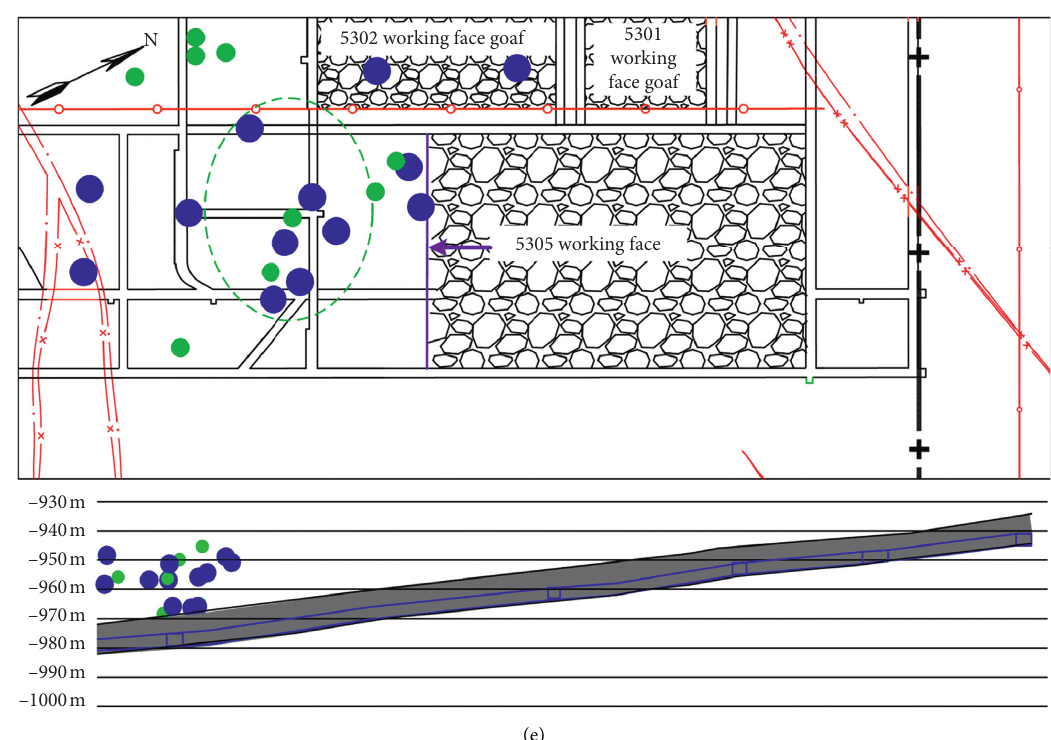
Figure 6: Spatial distribution evolution of microseismic events before the rock burst appearance (July 19–23). (a) July 19, (b) July 20, (c) July 21, (d) July 22, and (e) July 23.